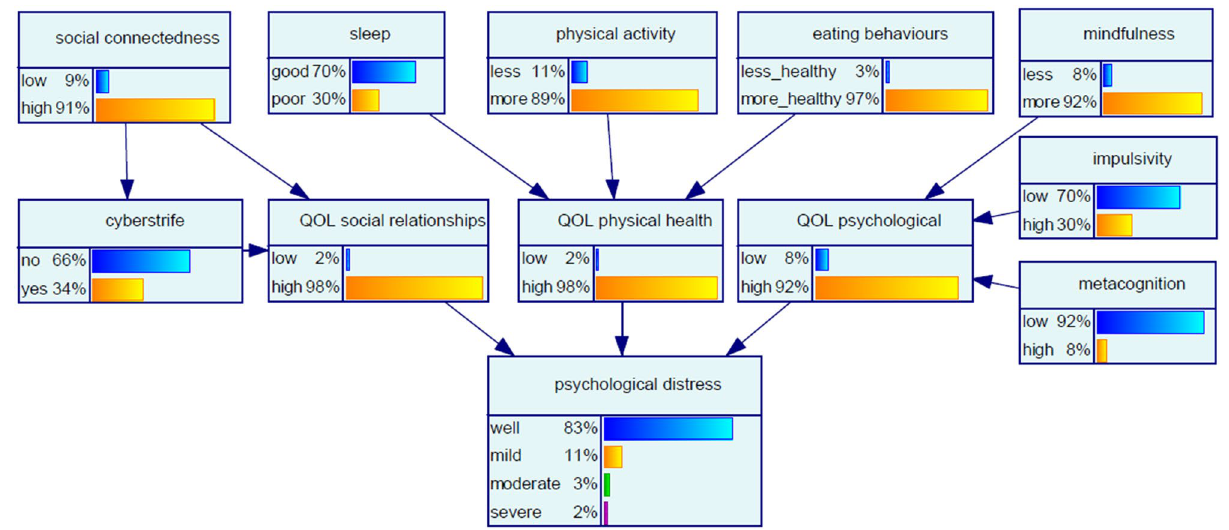
Figure 1. Baseline Bayesian network for risk of psychological